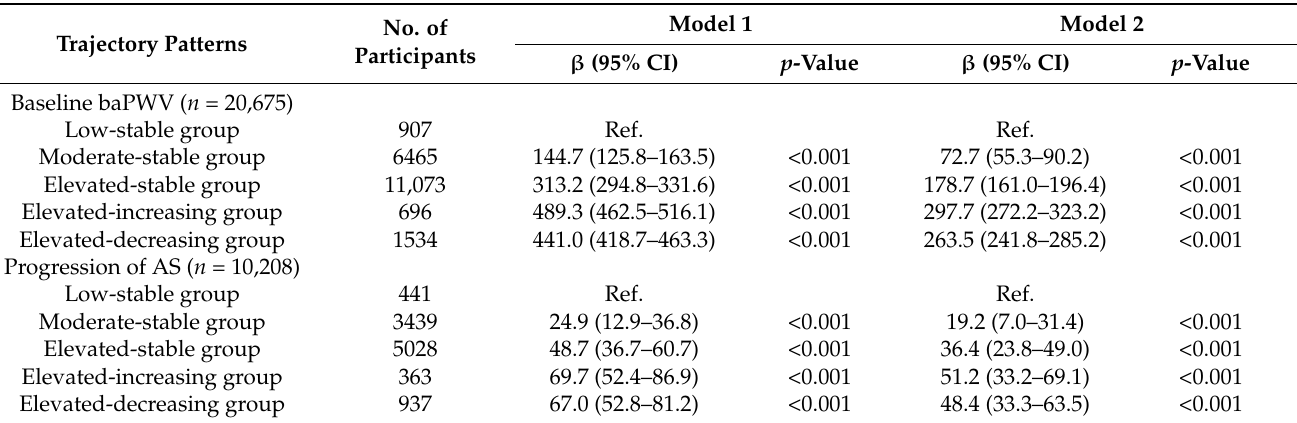
Table 3. Associations of the SBP trajectories with the baseline baPWV and progressive baPWV in non-hypertensive participants.